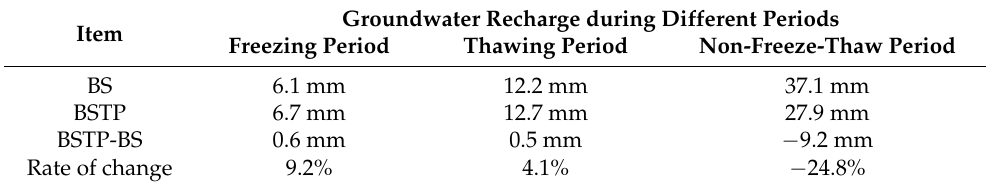
Table 12. Influences of temperature and precipitation on groundwater recharge